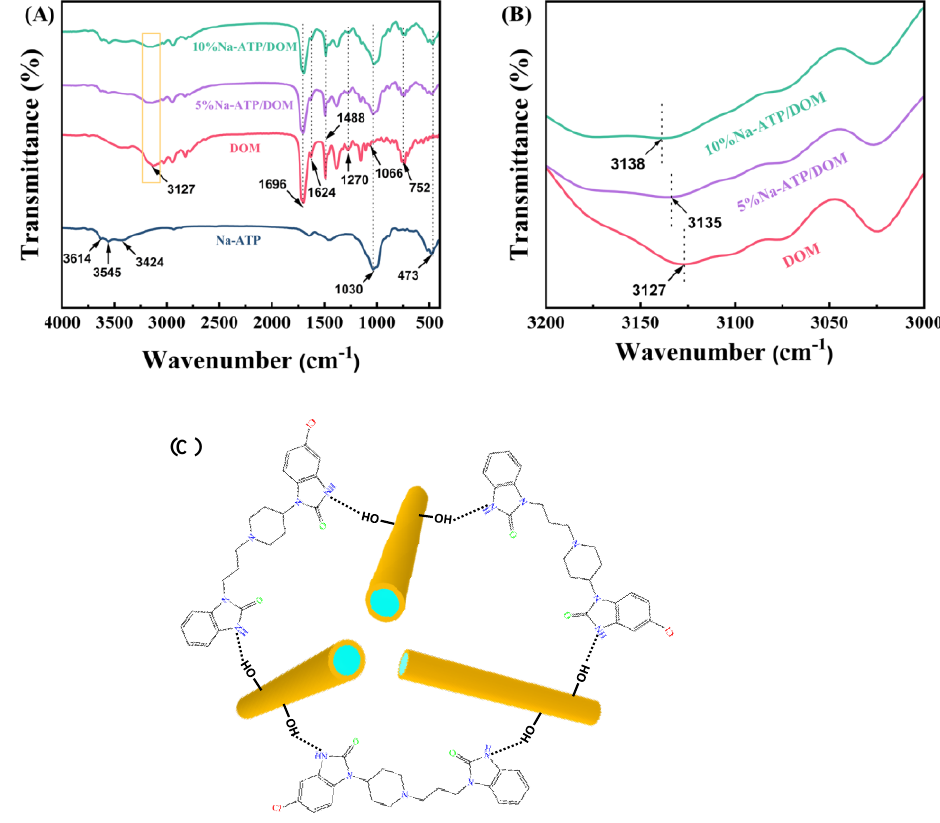
Figure 2. ( A ) FTIR spectrum of Na-ATP, DOM, 5%Na-ATP/DOM and 10%Na-ATP/DOM; ( B ) ampli- fied spectrum of the marked area in ( A ); ( C ) Mechanism of hydrogen bond interaction between DOM molecules and DOM molecules and Na-ATP.